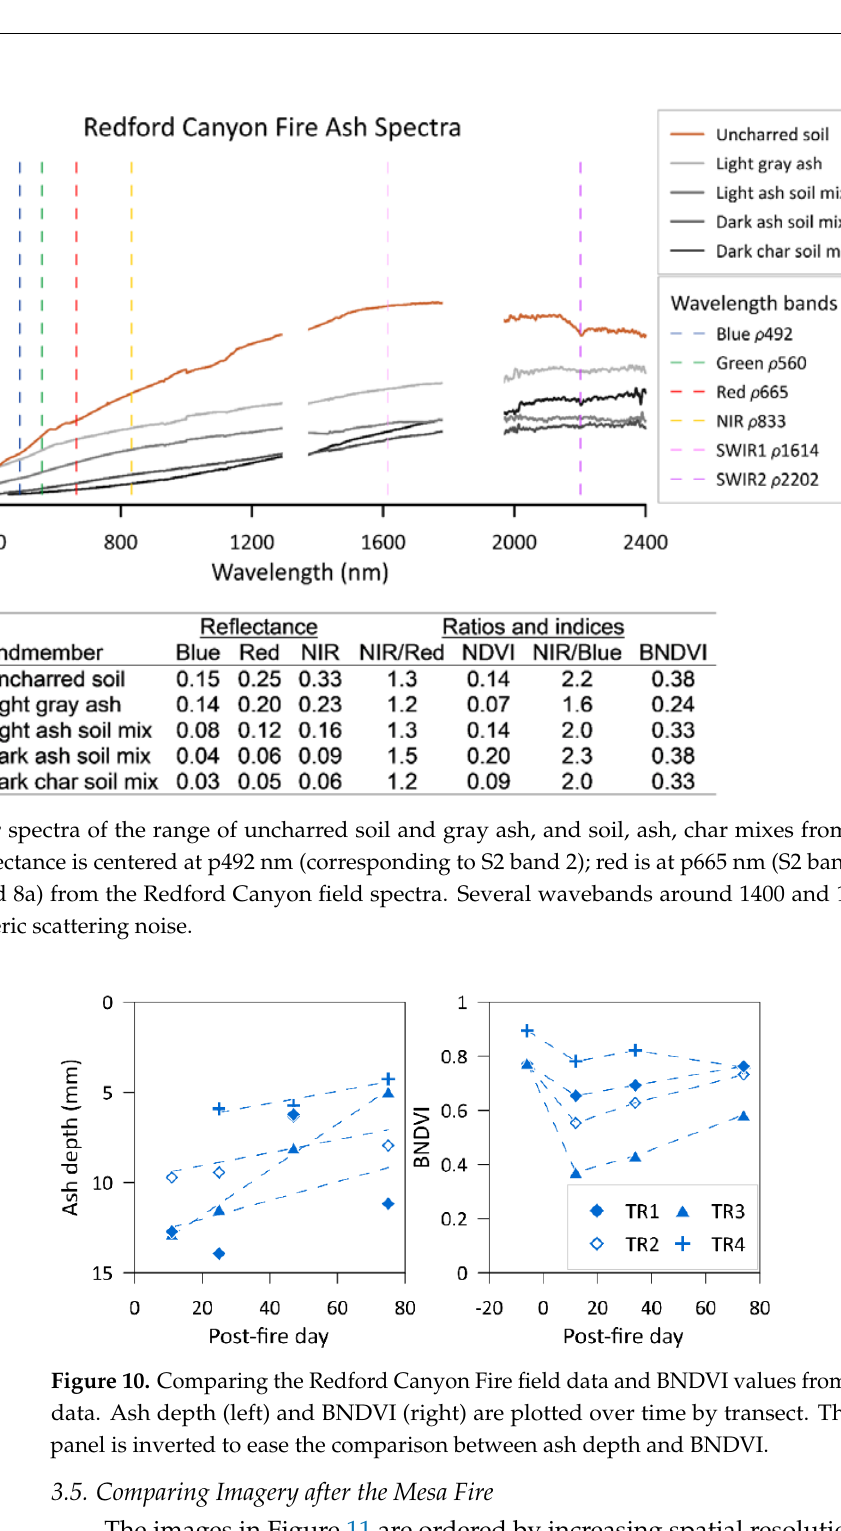
Figure 10. Comparing the Redford Canyon Fire field data and BNDVI values from Sentinel-2 spec- tral data. Ash depth (left) and BNDVI (right) are plotted over time by transect. The y-axis on the left panel is inverted to ease the comparison between ash depth and BNDVI.